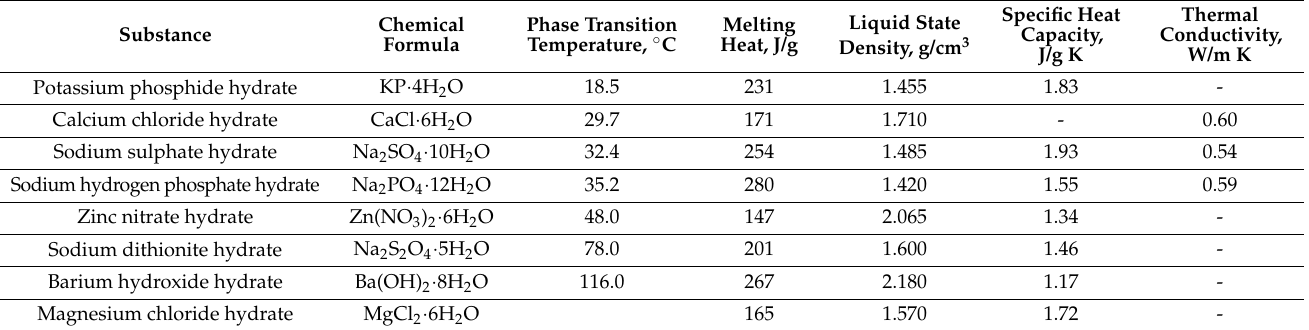
Table 3. Thermophysical properties of salt hydrates